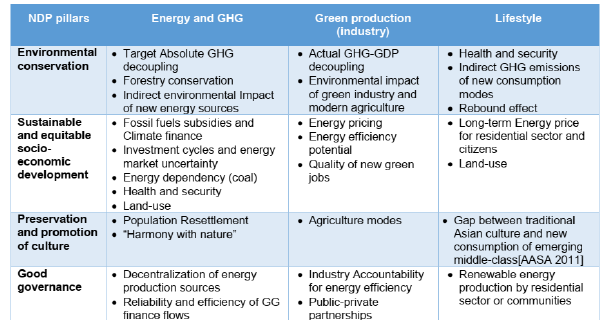
Figure 1. Development of rooftop solar and utility scale solar [1] Anasuya Gangopadhyay et al [11] studied a 100kW Figure 2. Main specificities of the Vietnam National Green Growth Strategy tasks